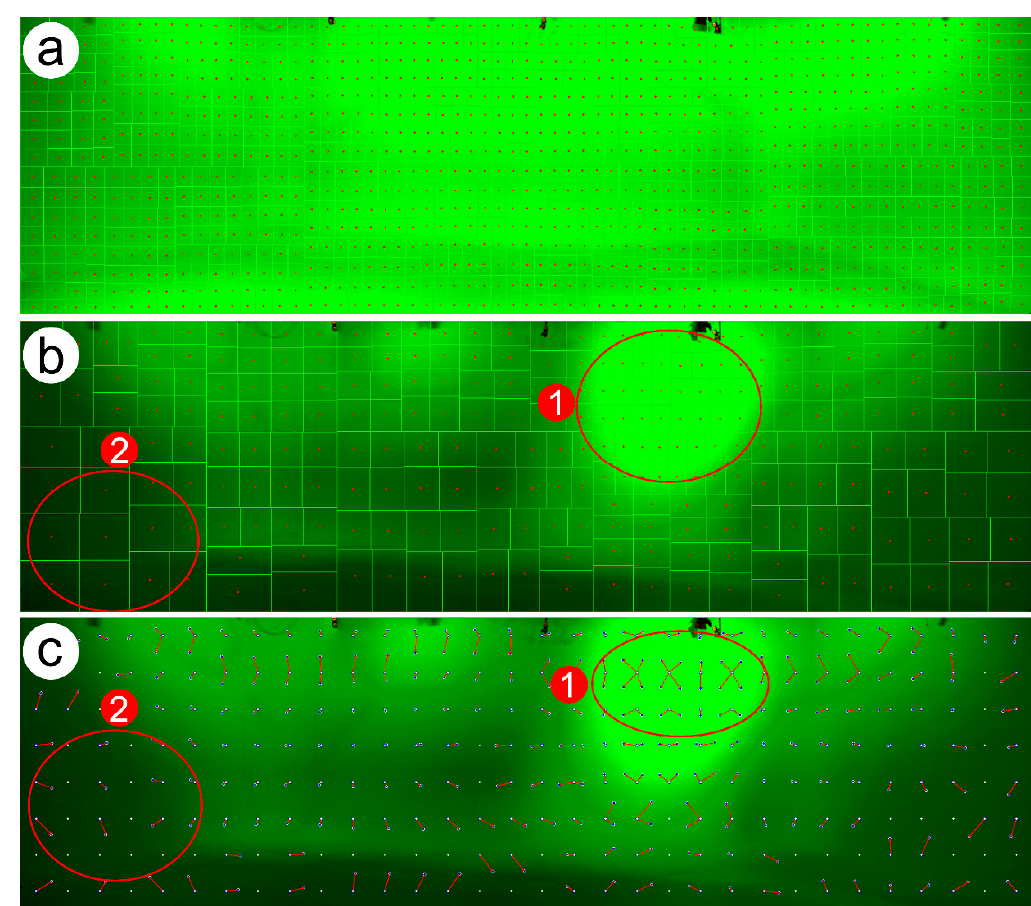
Figure 7 . Correctly illuminated cyclorama subdivided in 1024 regions. All the regions have a similar size and the centroids tend to be located in their geometric center (a) . Image subdivided in 256 regions. In the “1” area, which is over-lighted the regions are smaller than in the “2” area, which is shadowed (b) . Image subdivided in 256 regions. In the “1” area, which is over-lighted, each ideal centroid has two or more real centroid correspondences. In the “2” area, which is shadowed, there are several ideal centroids which have no real correspondent (c) .